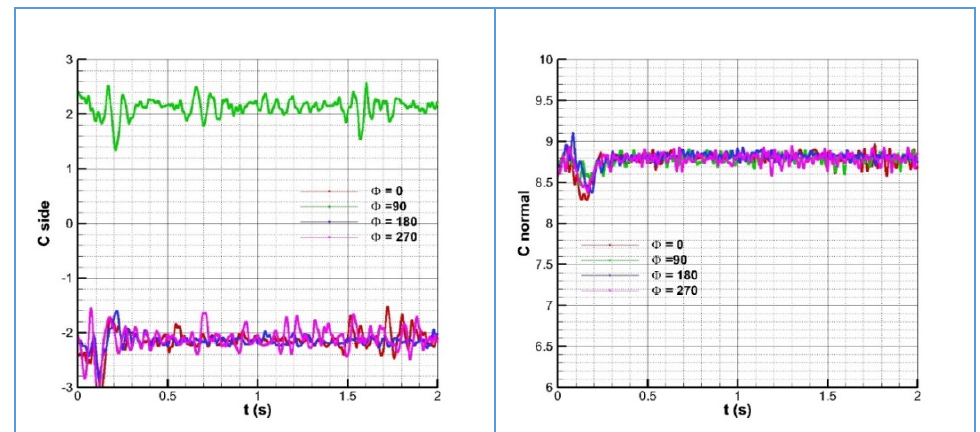
Figure 5. Time history for the side and normal force coefficients at several orientation angles for the case at Mach = 0.2, Re = 2 × 10 6 and angle of attack α = 45 deg. Structured grid.